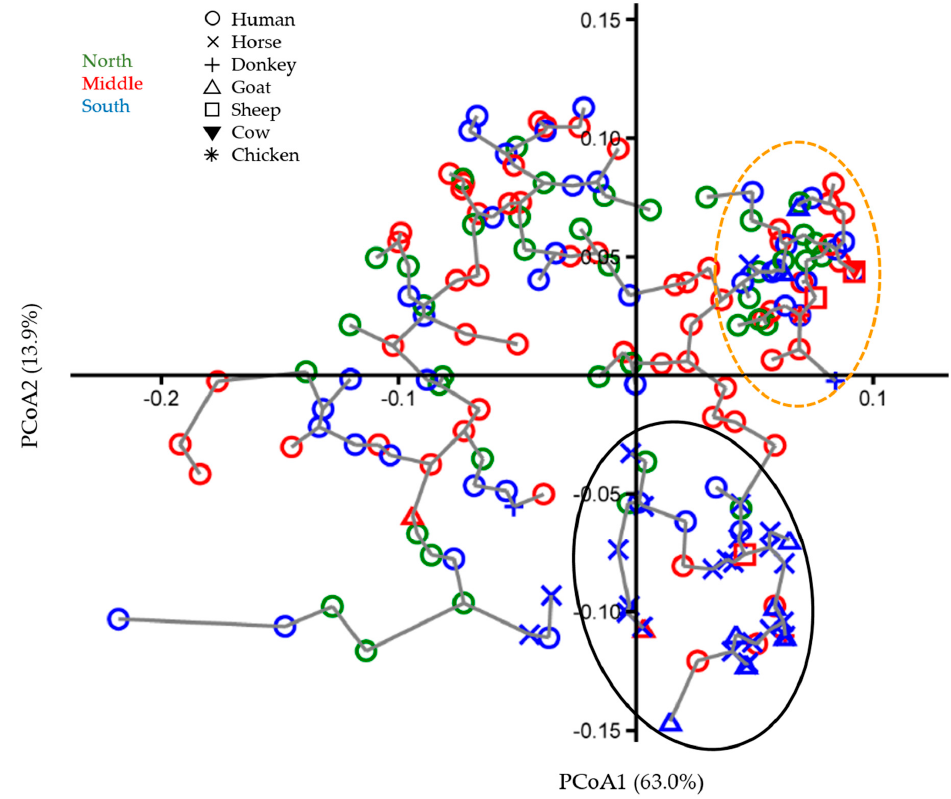
Figure 1. Principle coordinates analysis plot (principal coordinate 1 vs. principal coordinate 2; combined percent variance explained = 77%), with minimum spanning tree, computed on the identity matrix for human and animal TTV isolates’ 5 ′ -UTR sequences. The geographical locations of isolates are in different colors. Isolates from different host species are represented by different symbols.